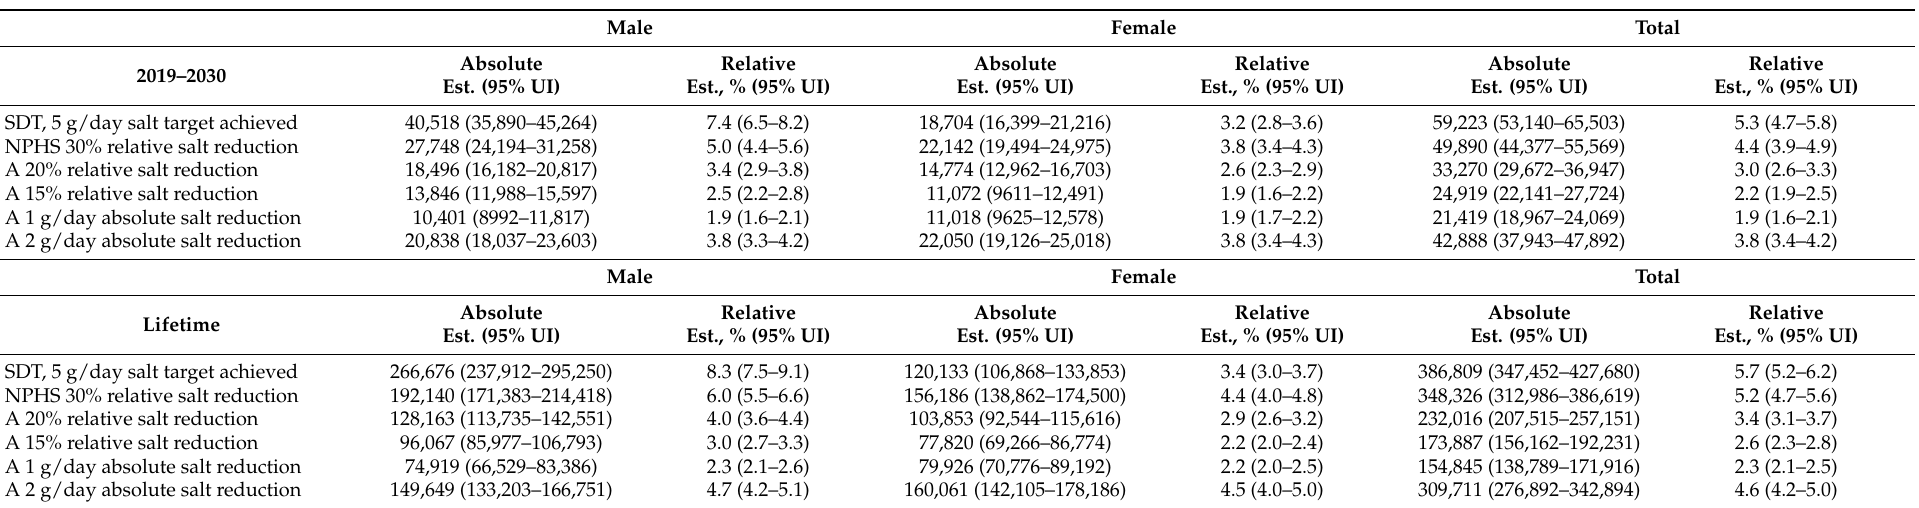
Table 2. Estimated reductions in cumulative incident CKD events in Australia between 2019 to 2030, and over the